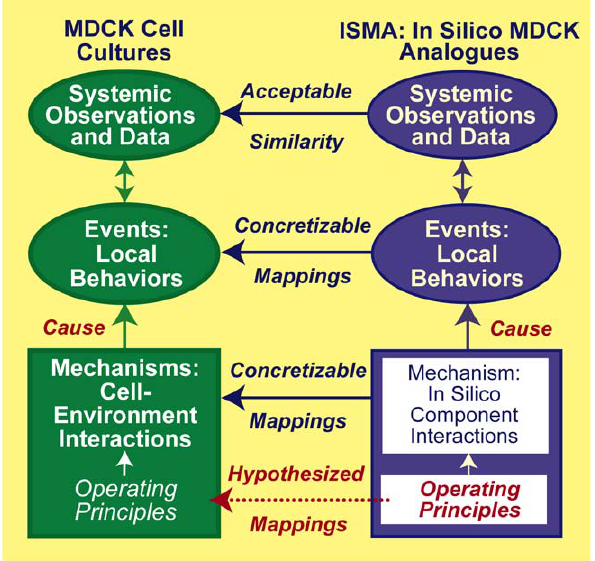
Figure 9. ISMA-to-in vitro cell culture mappings. Left: MDCK cell cultures are the referent wet-lab systems. During experiments, cells draw on genetically controlled operating principles, and cystogenesis is the result. Influential mechanistic details are reflected in the collected data. Right: an abstract mechanistic description, a set of targeted attributes, and specifications paired to those attributes direct analogue design. Software components are designed, specified, coded, verified, and assembled guided by that mechanistic description. The product of the process is a collection of abstract mechanisms rendered in software. A clear mapping is intended between ISMA CELLS , their axioms and operating principles, and MDCK CELL and INTRACELLULAR details. Relative similarity is controlled in part by parameterizations. Importantly, that mapping can be concretized iteratively. Compilation and source code execution gives rise to a working ISMA. Its dynamics are intended to represent abstractly corresponding dynamics (both observed in movies and believed to occur) within cultures during ten-day experiments. That mapping can also be concretized iteratively. Measures of CYSTOGENESIS provide time series data that are intended to be quantitatively similar (according to prespecified criteria) to corresponding measures of MDCK cell cystogenesis. Achieving increasingly stringent SMs provides degrees of validation. (Figure 7) altered CYSTOGENESIS details only marginally, primarily because CELL DEATH frequency was already low (Figure 5B). Lin et al. [17] hypothesized that apoptosis is crucial for lumen formation in MDCK cysts, but they reached that conclusion based on observations of cystogenesis in collagen culture only. Martı´n- Belmonte et al. [9] observed that apoptosis within Matrigel